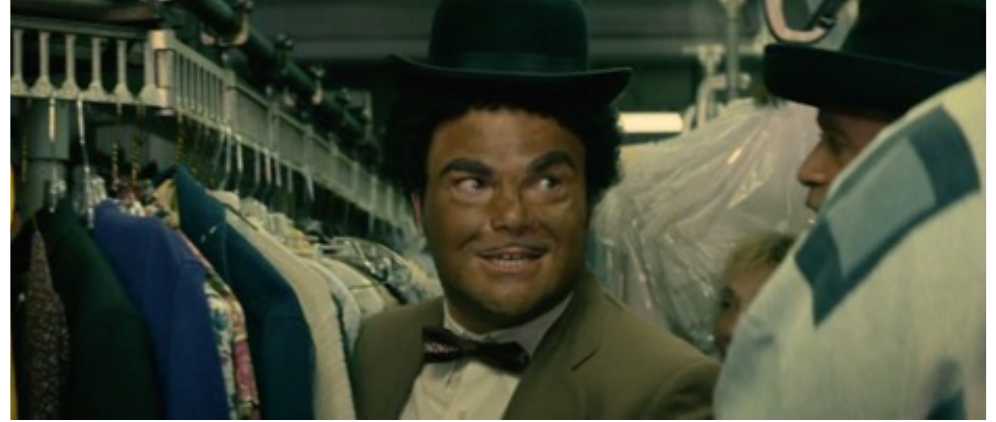
Figure 7. Jerry (Jack Black) in blackface and a failed attempt to play Fats